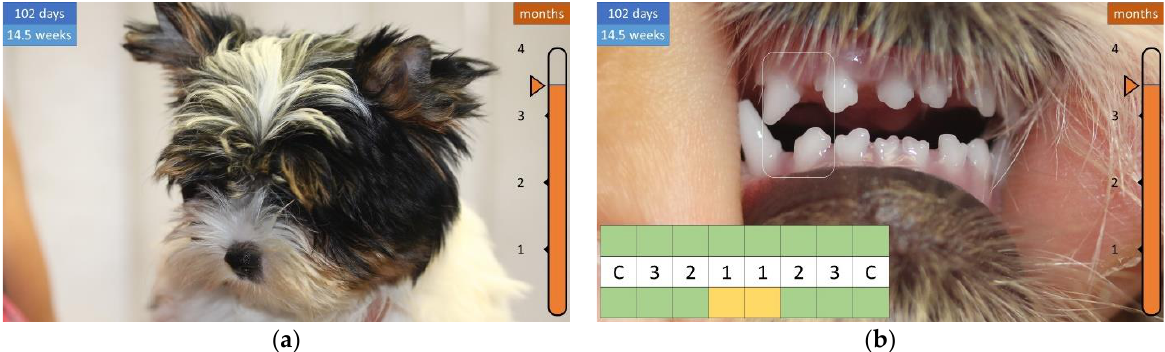
Figure 11. Development of the coat and teeth in a 14.5-week-old puppy. ( a ) Long coat that can be combed. ( b ) Distance between the lower teeth.